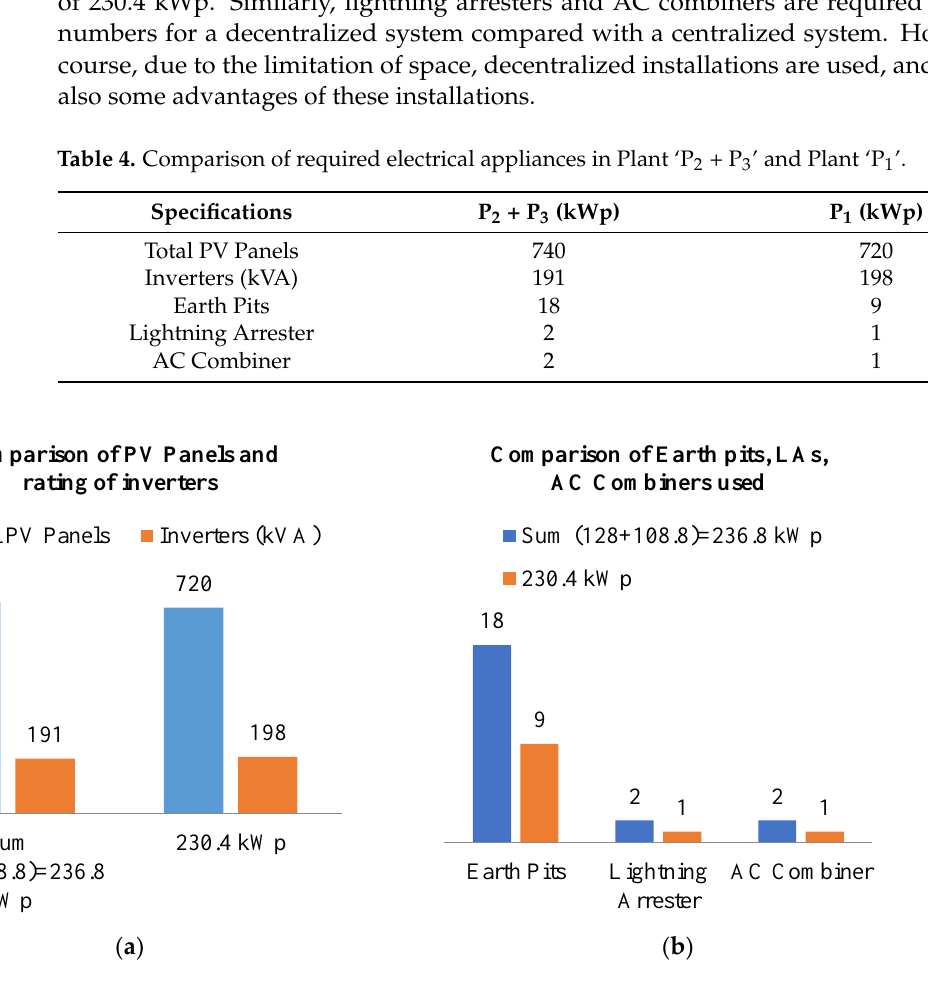
Figure 4. ( a ) Comparison of required rating of inverters, SPV panels in Plant ‘P 2 + P 3 ’ and Plant ‘P 1 ’ . ( b ) Comparison of required Earth Pits, Lightning Arresters, AC Boxes in Plant ‘P 2 + P 3 ’ and Plant ‘P 1’ .